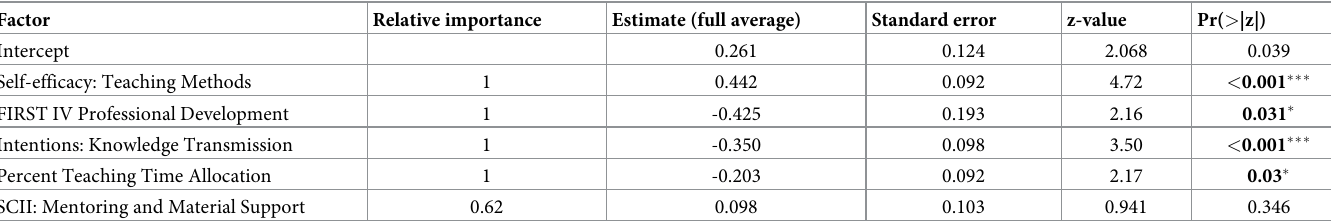
Table 5. Average model results for RTOP scores for both FIRST IV and comparison faculty (N = 64).